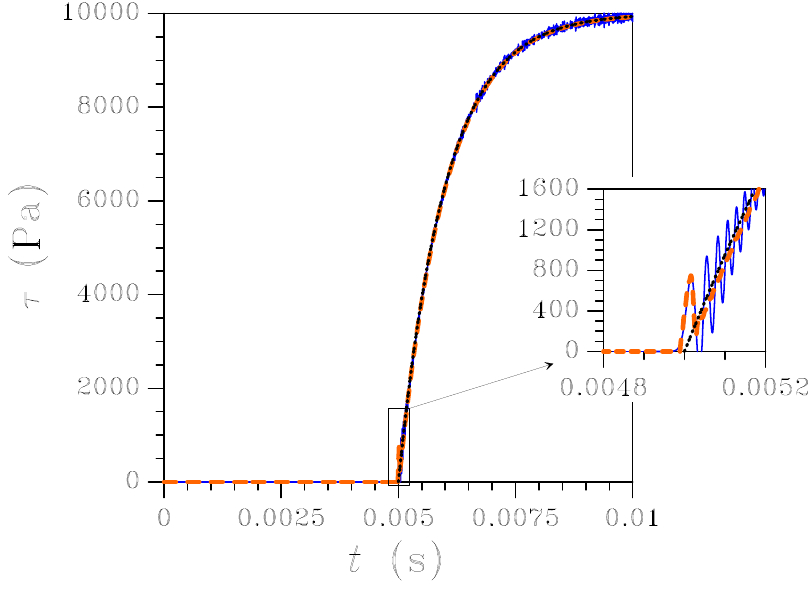
Figure 12. Wave propagating along an interface-containing homogeneous rod ( E N/m 3 ) discretized with an unstructured mesh: evolution in time of the normal traction τ at the interface. Black dotted line: analytical solution; blue solid line: FE solution; orange dashed line: newly proposed FE-FCT